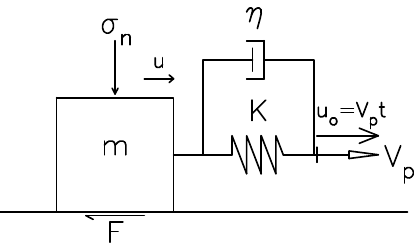
Figure 2. One-body spring-slider model. In the figure, t , m , K , η , V p , σ n , F , u , and u o denote, respectively, the time, the mass of the slider, the spring constant, the damping coefficient, the driving velocity, the normal stress, the frictional force, displacement of the slider, and the equilibrium location of the slider (after Wang,